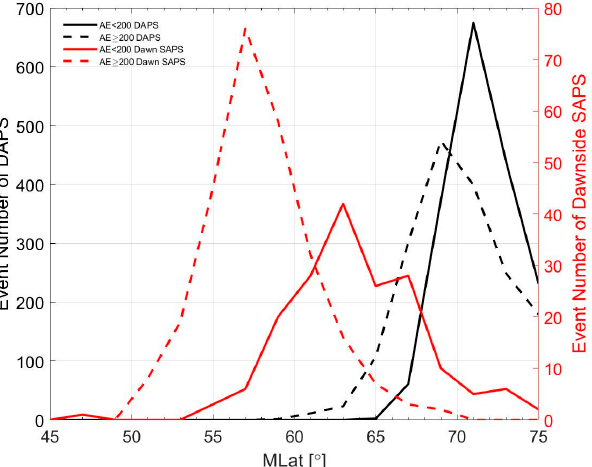
Figure 2. The magnetic latitude (MLat) distributions of DAPS and dawnside SAPS event numbers in the Northern Hemisphere observed by DMSP F16 at different AE levels. The black lines indicate the DAPS, and red lines denote the SAPS. The solid line represents AE < 200, and the dashed line represents AE ≥ 200.